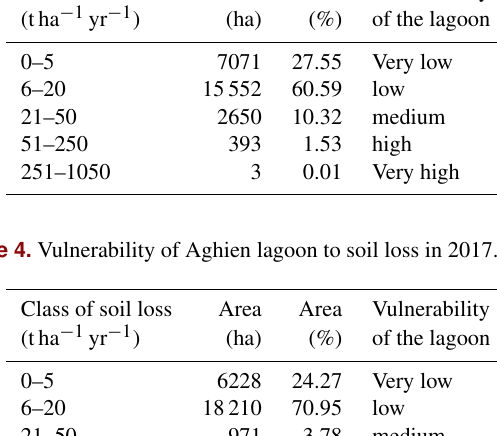
Table 3. Vulnerability of Aghien lagoon to soil loss in 2016. Class of soil loss